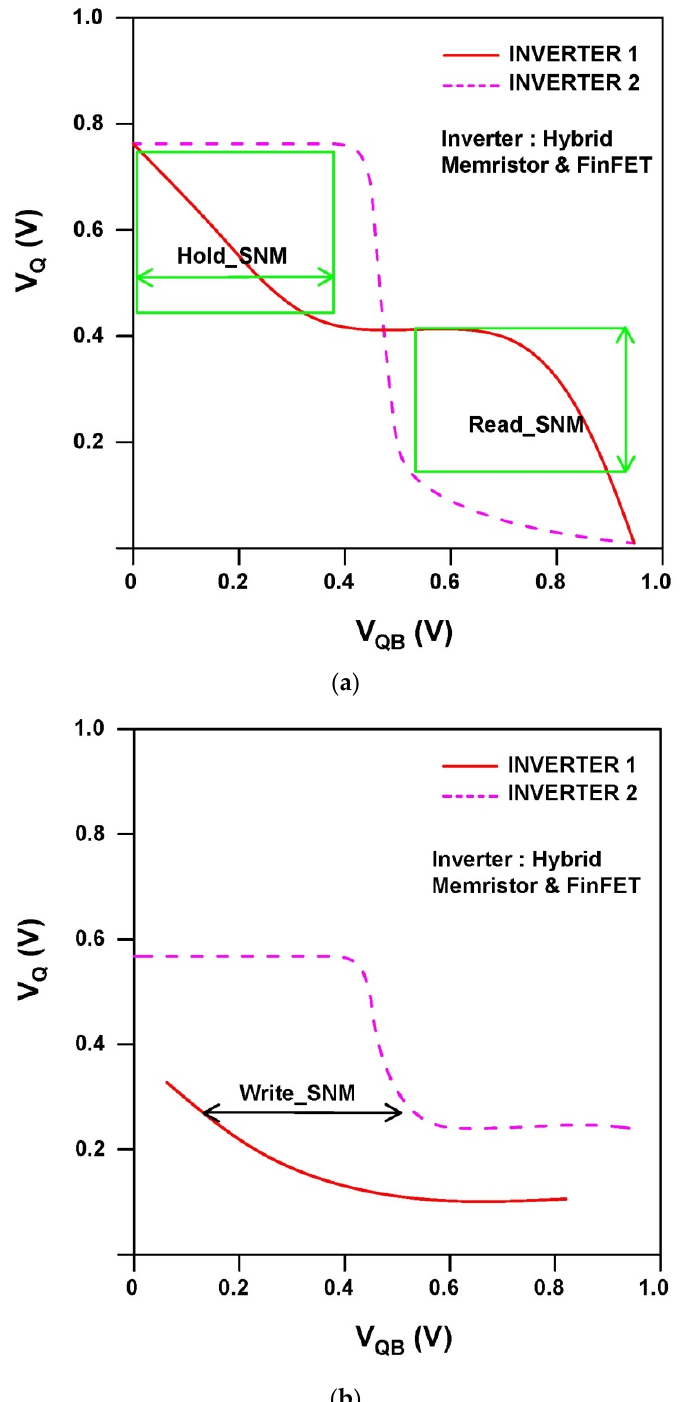
Figure 15 . Proposed hybrid FinFET and Ti/SiO 2 /Si(n++)/TiN Memristor 6T ‐ SRAM. ( a ) Hold and Figure 15. Proposed hybrid FinFET and Ti/SiO 2 /Si(n++)/TiN Memristor 6T-SRAM. ( a ) Hold and Read Static Noise Margin (SNM). ( b ) Write SNM . Read Static Noise Margin (SNM). ( b ) Write Table 1. Comparison of Power, Delay and Area for various SRAM implementations.